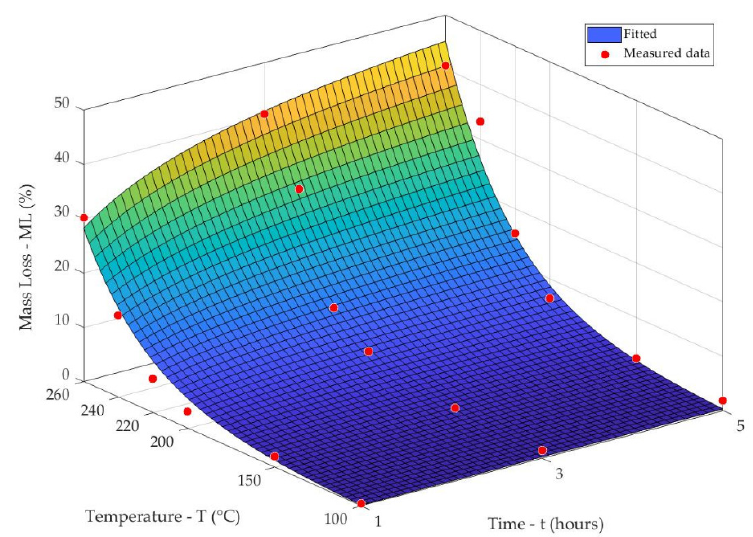
Figure 1. Mass loss values of the thermally treated spruce wood samples according to the time– temperature function: ML–T = (0.050·e T/37.310 − 0.378) · t/(0.874 + t); R 2 = 0.957.